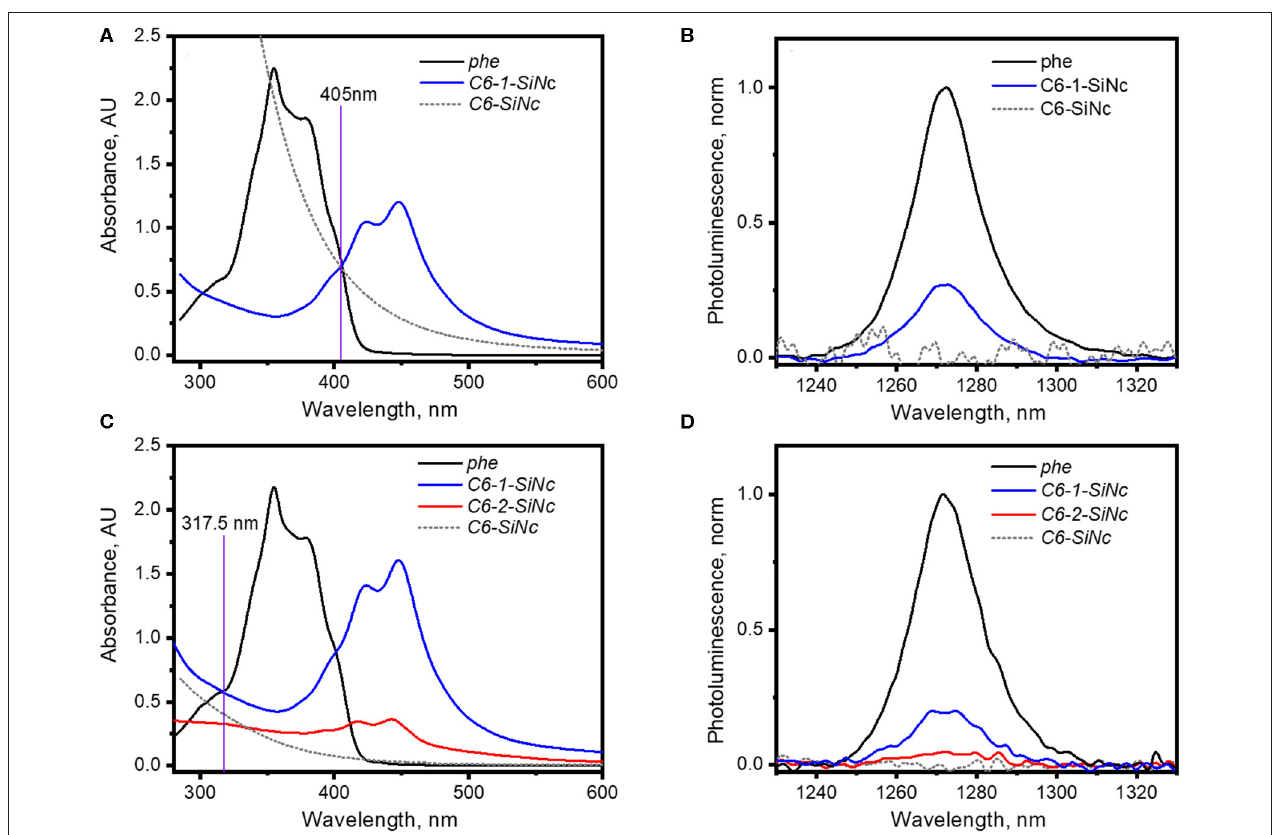
FIGURE 4 | (A) UV-Vis absorption spectra of solutions of phe, C6-SiNCs and C6-1-SiNCs in cyclohexane used for the generation of 1 O 2 with 405nm laser; (B) 1 O 2 phosphorescence excited via irradiation of solutions of phe , C6-SiNCs and C6-1-SiNCs with 405nm laser (excitation intensity of 75mW); (C) UV-Vis absorption spectra of solutions of phe , C6-SiNCs , C6-1-SiNCs and C6-2-SiNCs in cyclohexane used for the generation of 1 O 2 with 317.5nm laser; (D) 1 O 2 phosphorescence excited via irradiation of solutions of phe , C6-SiNCs , C6-1-SiNCs and C6-2-SiNCs with 317.5nm laser (excitation intensity of